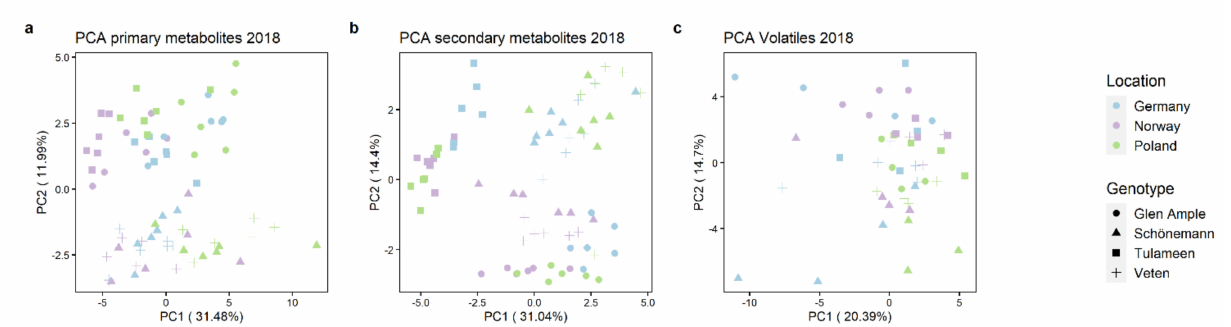
Figure 4. Heatmap visualization of raspberry volatile compounds identified in 2018 in two different harvests. Each value represents the normalized (median-centered and log 10 -transformed) mean of three biological replicates, with red and blue colors denoting relatively high and low intensities. Metabolites are clustered based upon Pearson correlation coefficients. Samples’ location and genotype are indicated with color labelling.